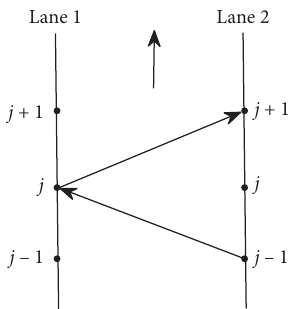
Figure 1: The physical model of traffic flow on two-lane